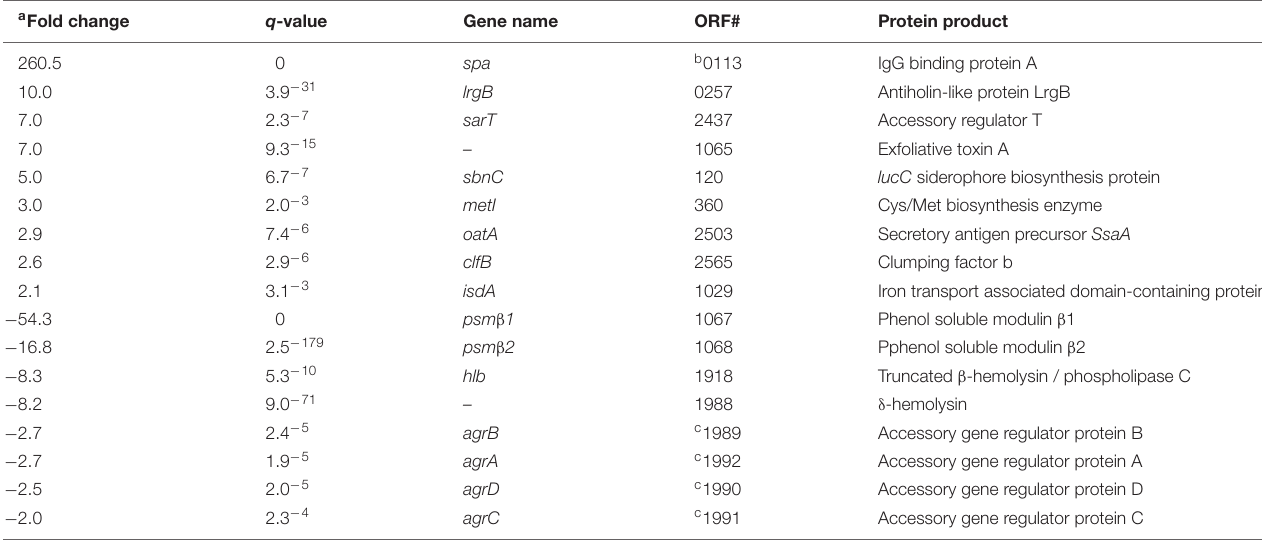
TABLE 1 | Transcriptional response of S. aureus to cocultivation with C. striatum